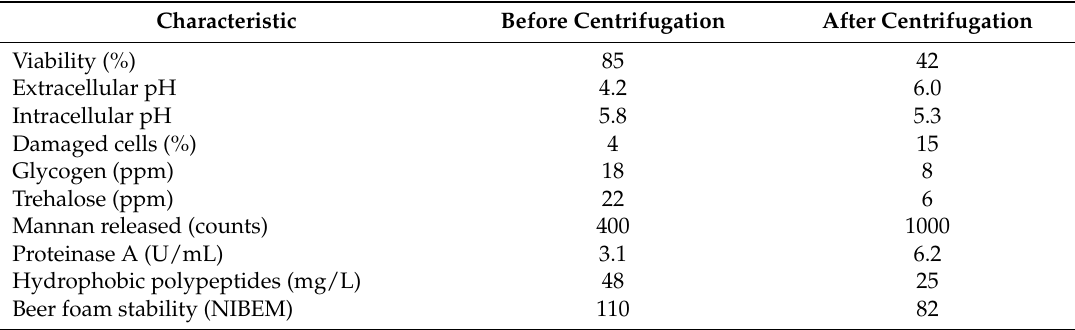
Table 3. Characteristics of yeast cells recycled nine times in 20 ◦ P wort and beer before and after centrifugation at high G-force [138]. Characteristic Before Centrifugation After Centrifugation 85 42